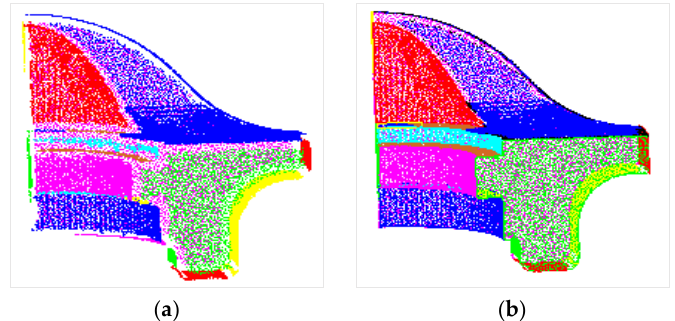
Figure 7. Comparison of results before and after patch expansion: ( a ) before patch expansion display and ( b ) after patch expansion display. The patches are marked by different colors.